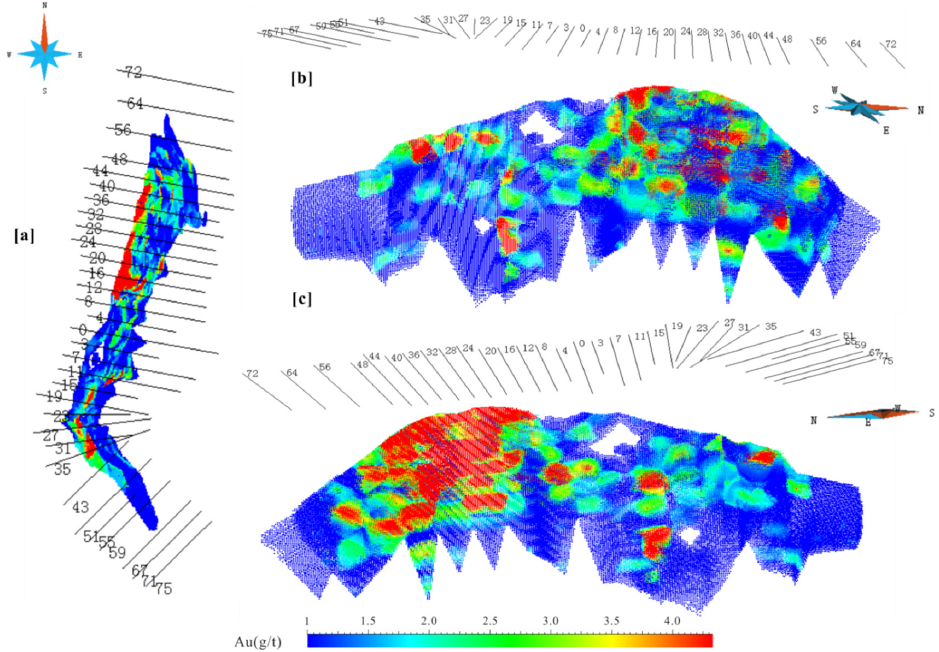
Figure 5. Above; 3D assay models showing the spatial distribution of gold grade of each voxel in the horizontal ( a ) and vertical ( b , c ) directions in the Axi deposit. horizontal ( a ) and vertical ( b , c ) directions in the Axi